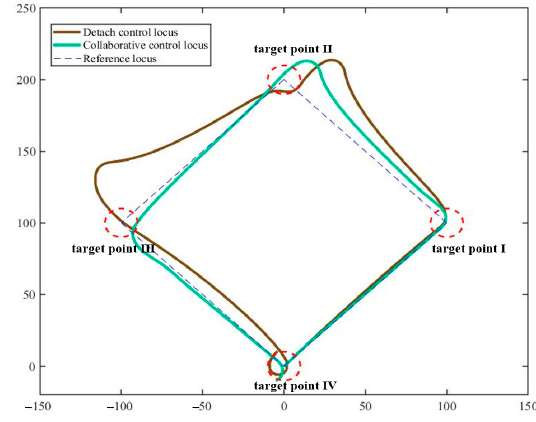
Figure 12. Four-point navigation path diagram. Table 5. Maximum deviation of the collaborative control and separation control.